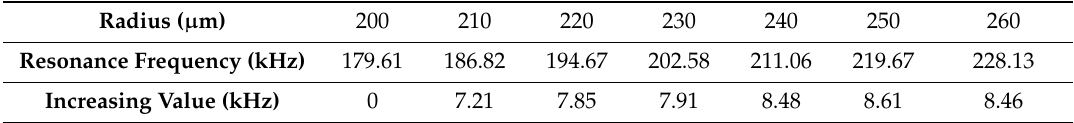
Figure 9. The FEA simulation results of parametric sweeping. ( a ) Deflection displacement under conditions of various radii, ( b ) the absolute value of admittance. Table 3. The resonan t frequencies with different radii of top electrodes. Radius ( μ m)